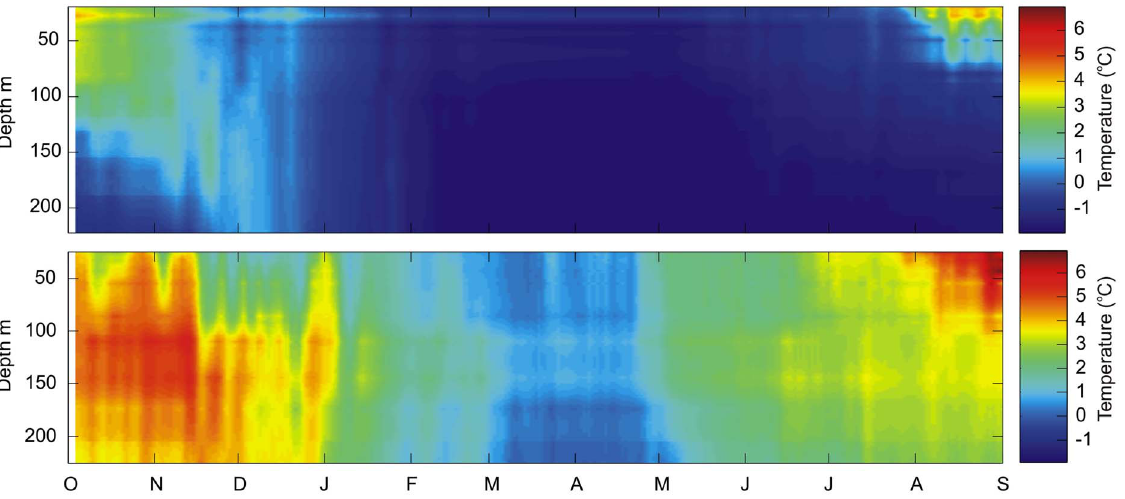
Figure 2. Seasonal temperature plots in an ‘‘Atlantic’’ and ‘‘Arctic’’ type fjord. Temperature plots from moored observatories between 4 th of October 2012 and 1 st of September 2013 in Rijpfjorden (upper) and Kongsfjorden (lower).